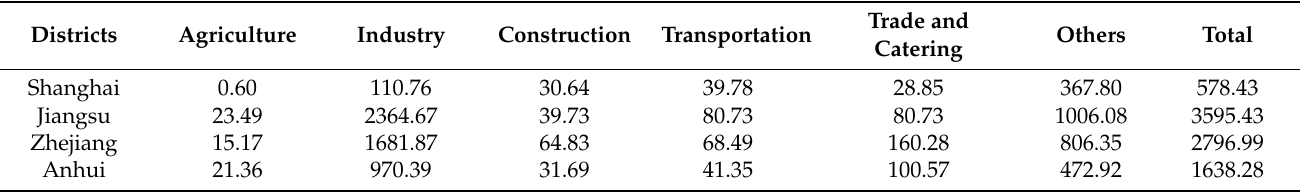
Table 6. Sectoral electricity consumption changes in regions (10 8